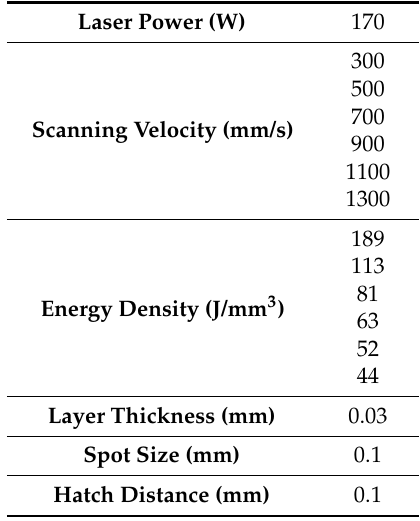
Table 2. Processing